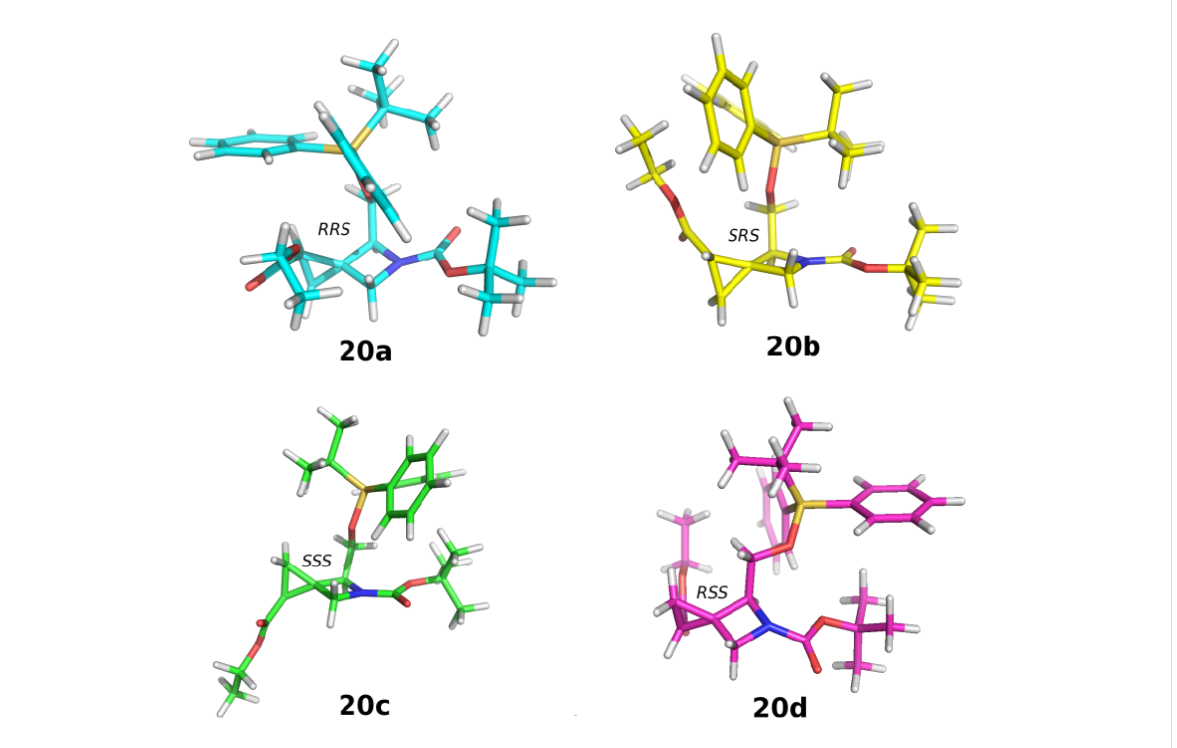
Figure 3: Representation of the lowest energy conformation of each diastereoisomers.